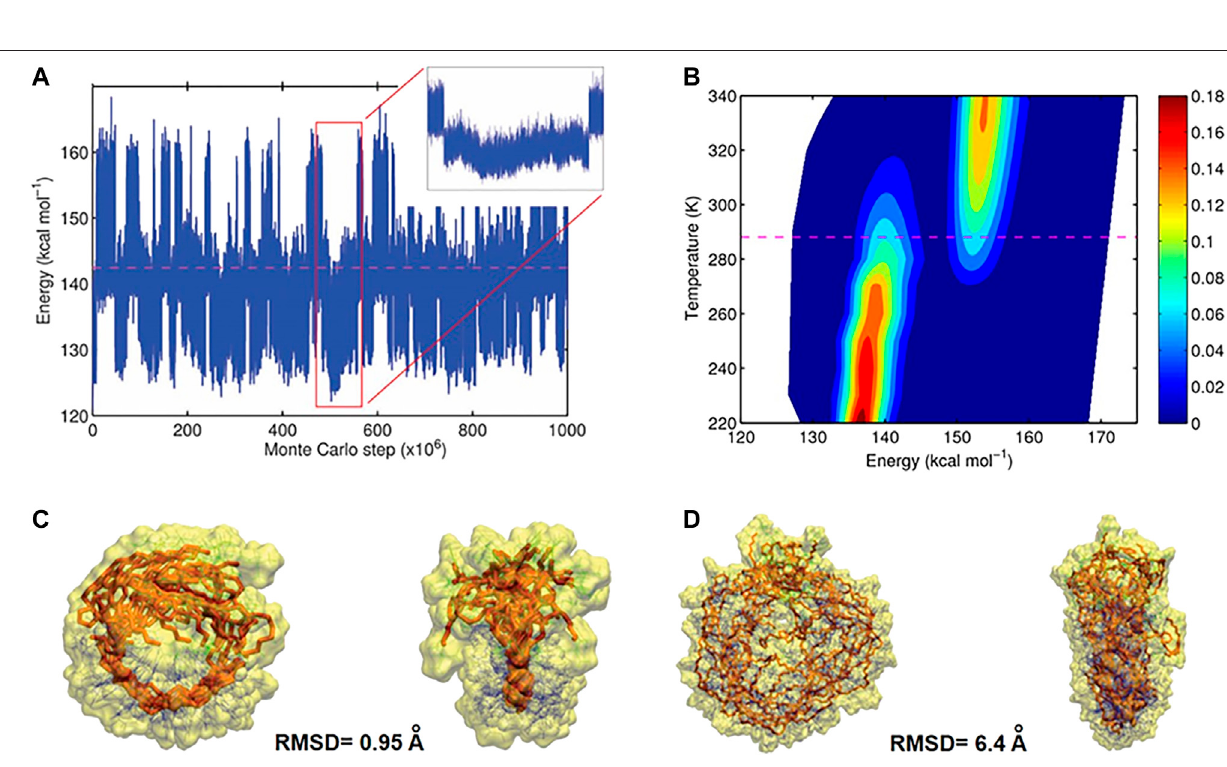
FIGURE 9 | (A) Energy of the conformations for L 50 as function of the number of steps. Large values of the energy correspond to open, small values closed conformations (B) , probability density pro fi le computed from the trajectory (red regions are more occupied than blue regions), indicating two-state folding behavior. At the transition temperature (dashed line) the occupation of both states is equally probable (C) , Front and side views of ten closed conformations obtained from uncorrelated closed intervals forpolymers withL 10 (D) Front and sideviewsoften closed conformationsobtained from uncorrelated closed intervals forpolymers with L 50 (Reproduced by permission of The Royal Society of